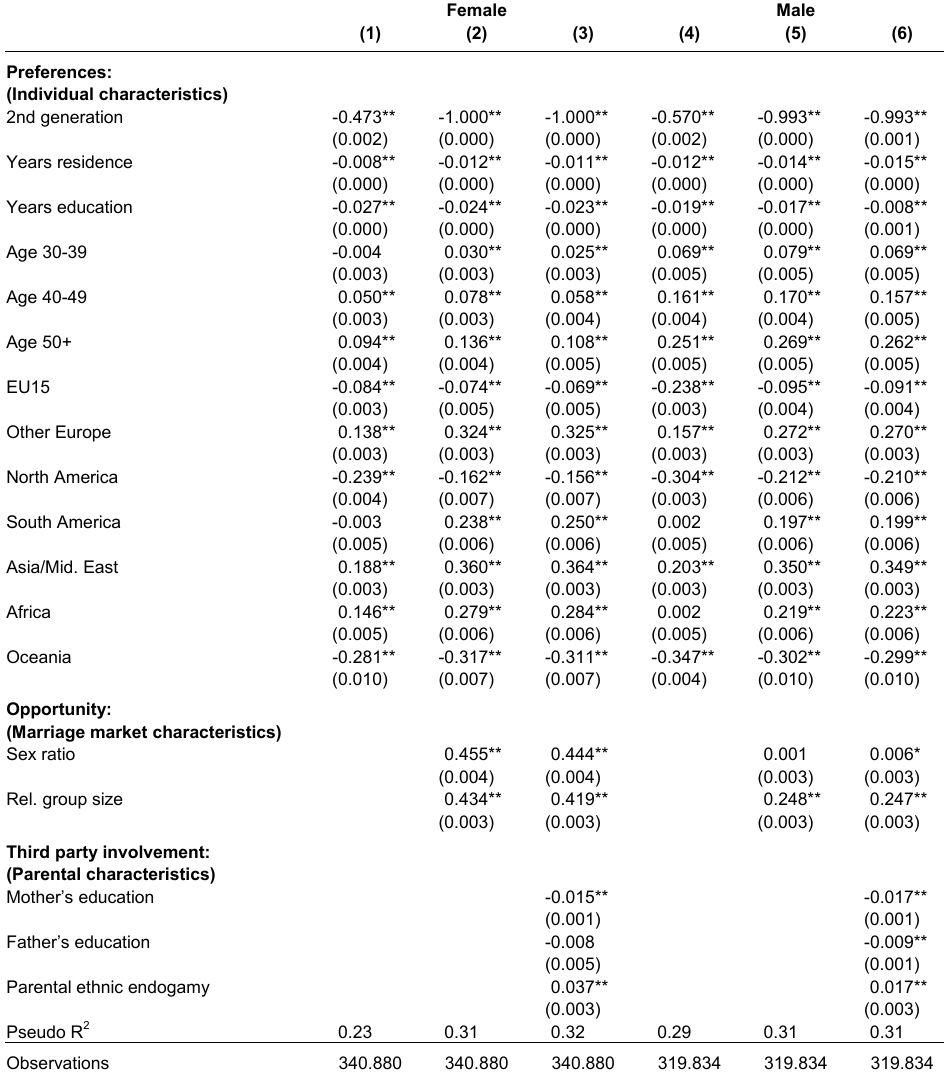
Table 3: The probability of ethnic